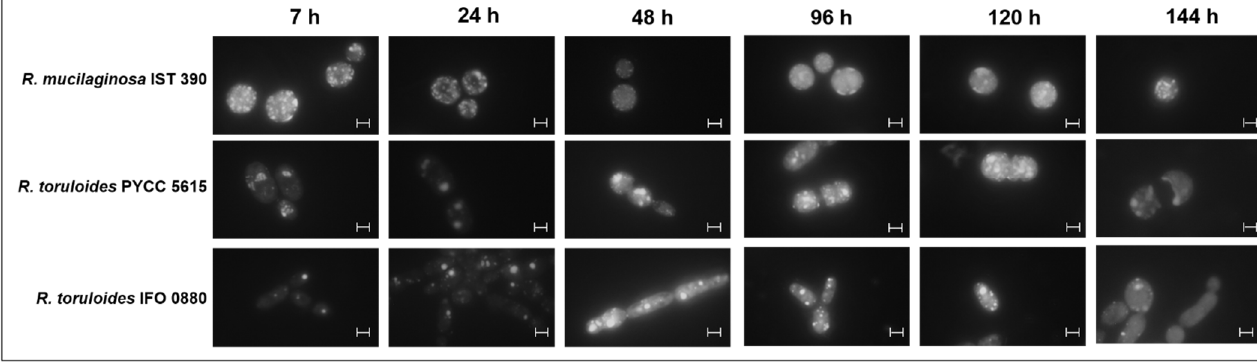
Figure 8. Microscopic observations of R. mucilaginosa IST 390, R. toruloides PYCC 5615 and R. toruloides IFO 0880 cells stained with Nile red fluorescence dye during cultivation in SBP hydrolysate H13-derived medium, as described in the Figure 7 legend. Cells were harvested during the growth curves shown in Figure 7. The arrangement, size and fluorescence intensity of the lipid droplets accumulated inside the cells was examined along yeasts’ cultivation. One of the different pictures taken at the same incubation times is shown as a representative example. The scale bars represent 5 µm.